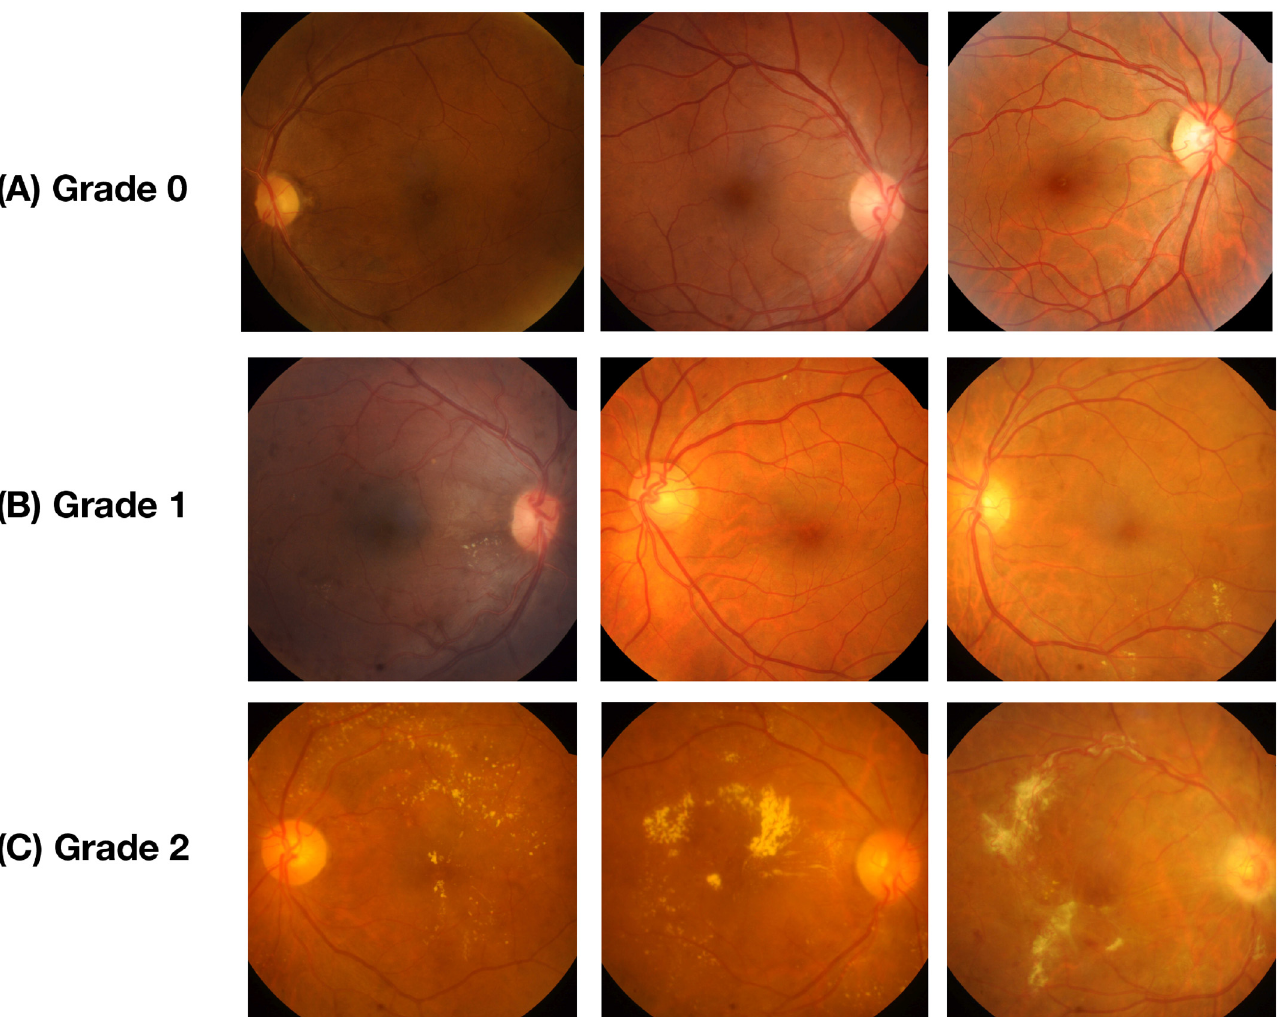
Fig 1. Representative fundus images with different pathological severity of DME. (A) Denotes the images of Grade 0 severity which have no hard exudates, (B) Represents Grade 1 severity which has exudates outside the radius of one disc diameter from the macula center, and (C) Denotes the fundus under the Grade 2 severity category, with exudates within the radius of one disc diameter from the macula